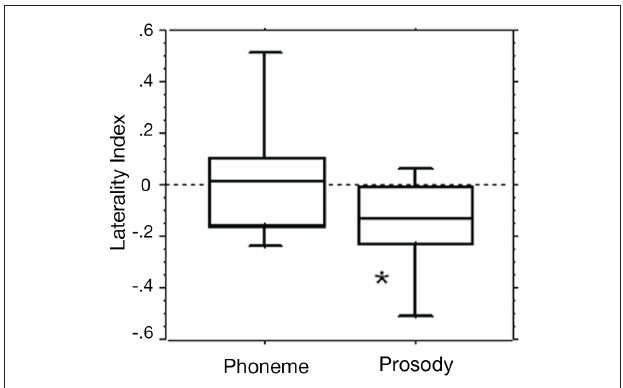
FIguRe 6 | Laterality indices for phonemic and prosodic conditions for each participant. Laterality index is above zero for left dominance and below zero for right dominance. Boxes, The quartiles; bars in the box, the medians; hinges, the ranges. * = p <